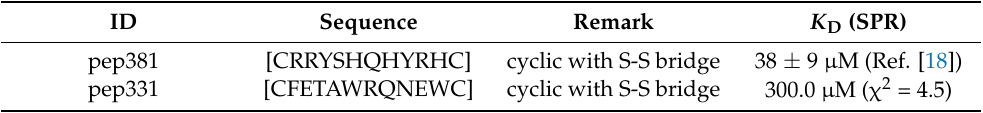
Figure 4. Overlap between peptides/ β 2m configurations as obtained by the design algorithm: ( a ) side and ( b , c ) top views. Color code: β 2m (blue), peptide pep381 designed for site A (cyan), and peptide pep331 designed for site B (pink). Both peptides are cyclic thanks to an intramolecular S-S bridge (yellow). β 2m size along selected directions is also indicated. Table 1. Selected peptides sequences and their surface plasmon resonance (SPR)-determined binding affinity ( K D ).